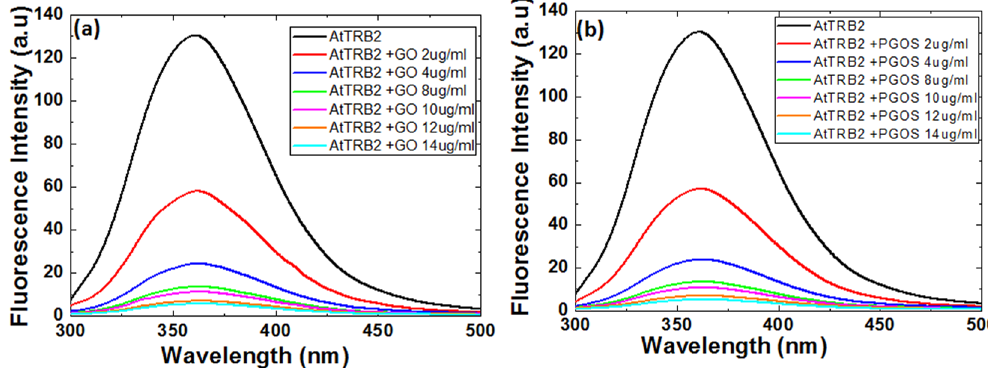
Figure 5. Quenching studies of AtTRB2 protein after treatment with ( a ) GO at different concentration and ( b ) at different concentration of PGOS using fluorescence